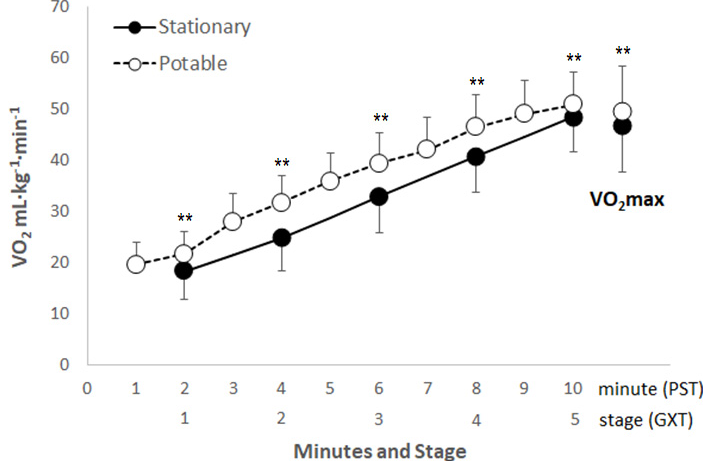
Figure 1. Scattergram of the measured oxygen uptake (VO 2 ) at each minute (or stage) and the maximal VO 2 in male and female adolescents. Asterisks (**) indicate statistically significant ( p < 0.01) di ff erences compared with the measured VO 2 from the stationary metabolic cart according to repeated-measures